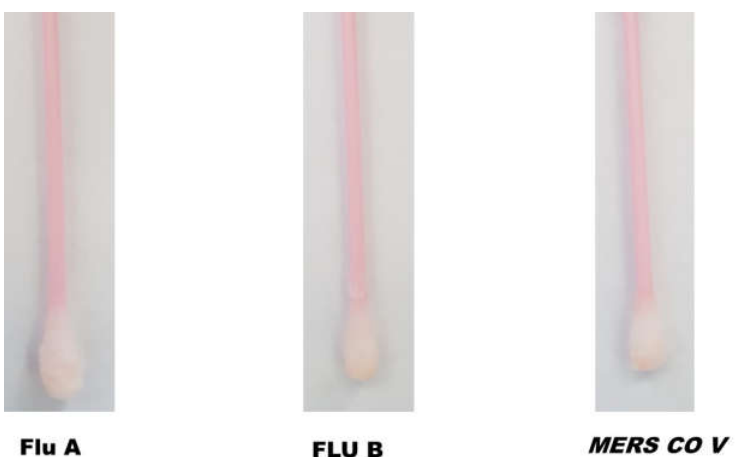
Figure 3. Cross-reactivity of SARS-CoV-2-fabricated Q-tips against other coronaviruses, including Flu A, Flu B, and MERS Flu A, Flu B, and MERS COV.